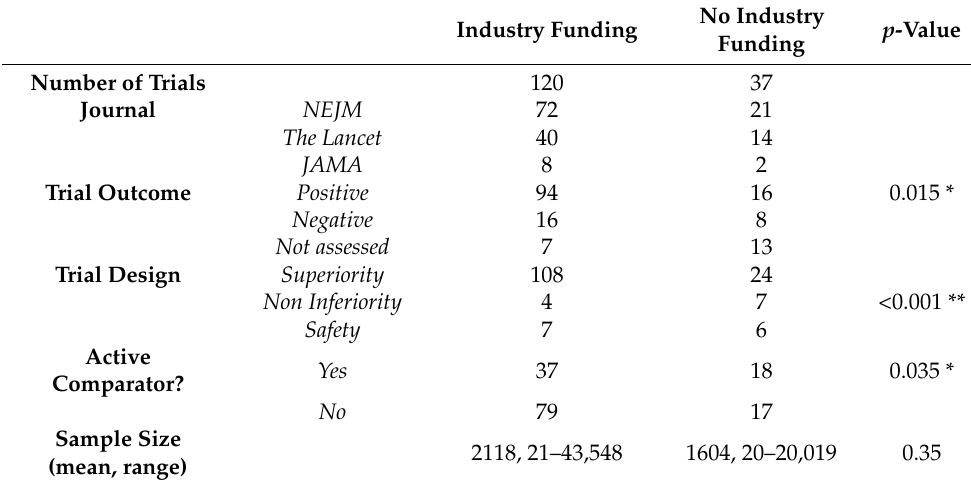
Table 2. Industry-funded vs. non-industry-funded trial characteristics.